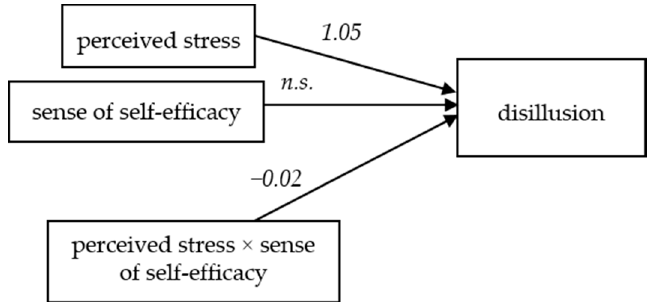
Figure 6. The model of relations between the perceived stress and disillusion, moderated by the sense of self-efficacy ( n.s.: not significant).